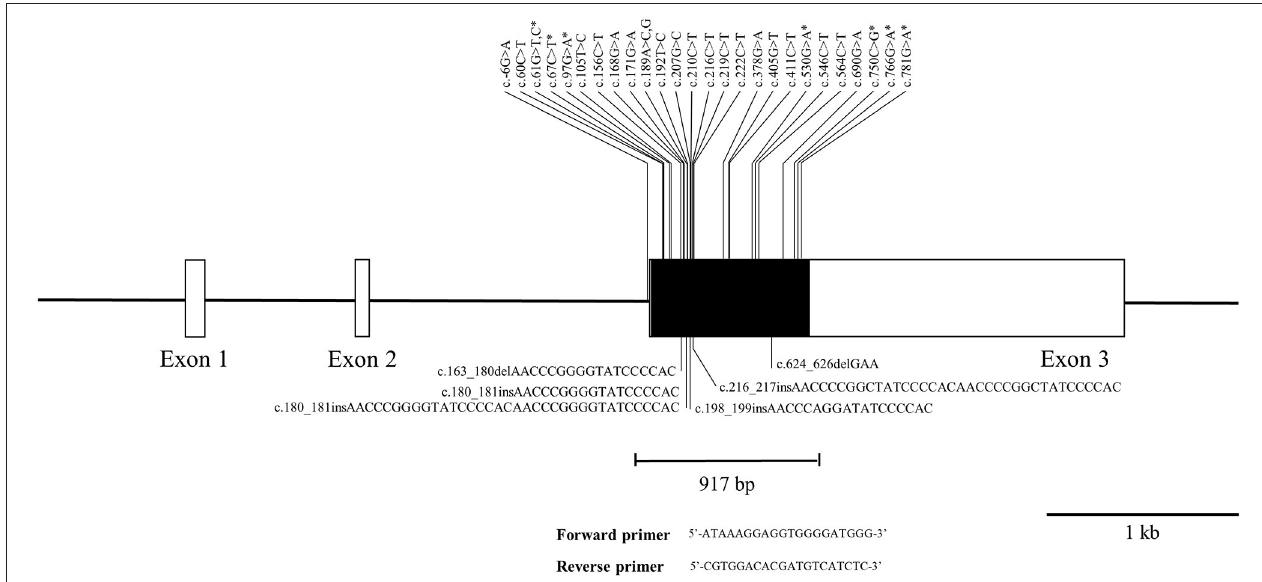
FIGURE 1 | Novel genetic polymorphisms of the pheasant prion protein gene ( PRNP ) found in this study. The open reading frame (ORF) is indicated by a shaded block and the 5’ and 3’ untranslated regions (UTRs) are indicated by white blocks. The edged horizontal bar indicates the region sequenced. Asterisks denote nonsynonymous single nucleotide polymorphisms (SNPs). Upper lines indicate the novel SNPs. The lower lines indicate the novel insertion/deletion polymorphisms.